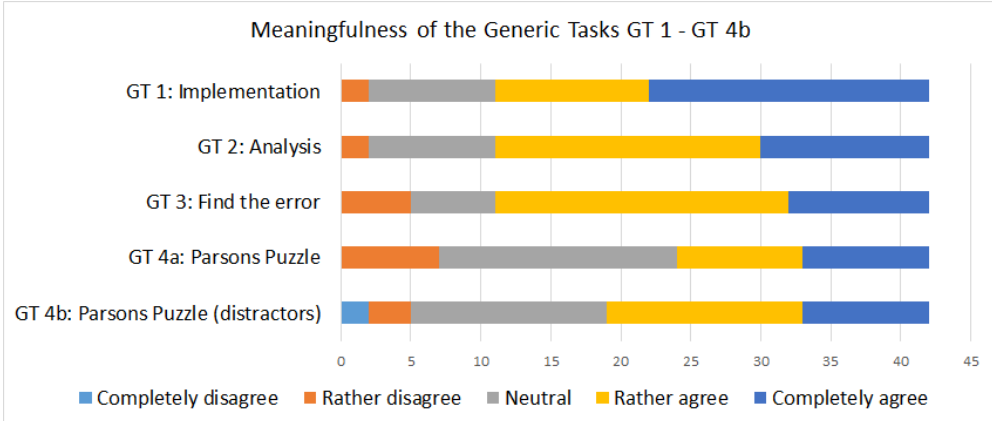
Figure 3. Agreement with the statement “Students can learn a lot when completing this task” for n = 14 raters aggregated for the three different algorithms, resulting in m = 42 answers per